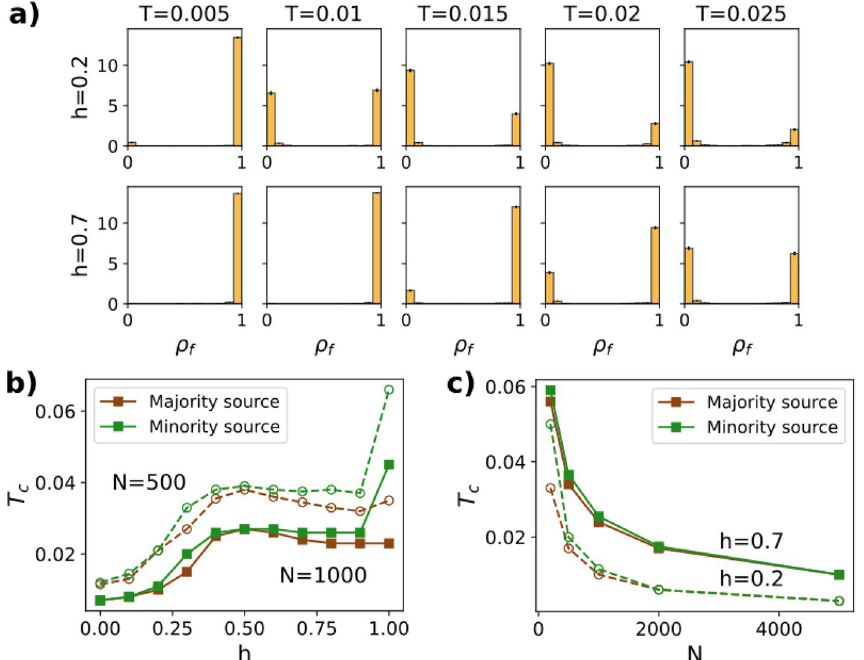
Figure 4. Critical threshold for Complex Contagion dynamics. ( a ) Histograms with the probability distribution of the final density of informed nodes, for a majority source and h = 0.2 (upper row) and h = 0.7 (lower row). The pdf is normalized so that the total area of each histogram equals one. Used parameters: N = 1000 nodes, m = 1 , M = 1000 realizations. ( b ) Critical threshold as a function of the homophily parameter, for minority and majority sources. Simulations were performed for two values of N : N = 500 (dashed line) and N = 1000 (solid line). ( c ) Critical threshold as a function of the number of nodes, for minority and majority sources and two values of the homophily parameter: h = 0.2 (dashed line) and h = 0.7 (solid line). In all simulations, the minority size was fixed to f a = 0.2